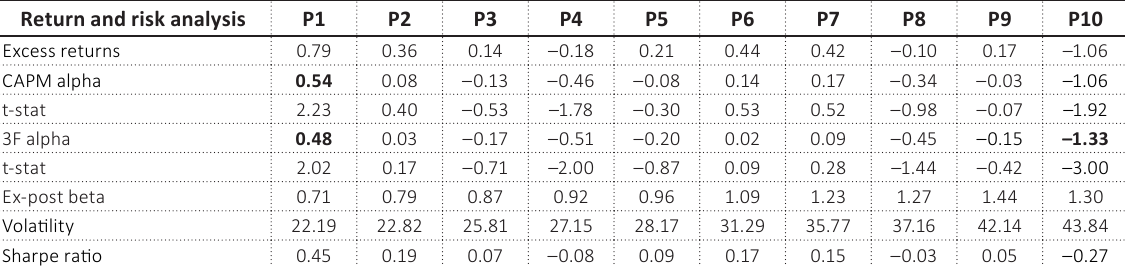
Table 5. Performance of portfolios sorted by